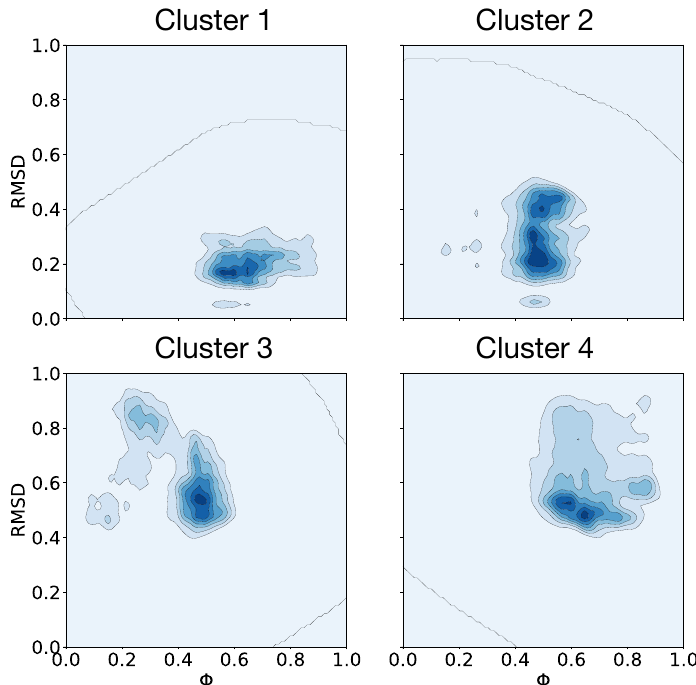
Figure 10. Density profiles for each cluster considering the RMSD and the FNC ( Φ ). Darker colors indicate denser